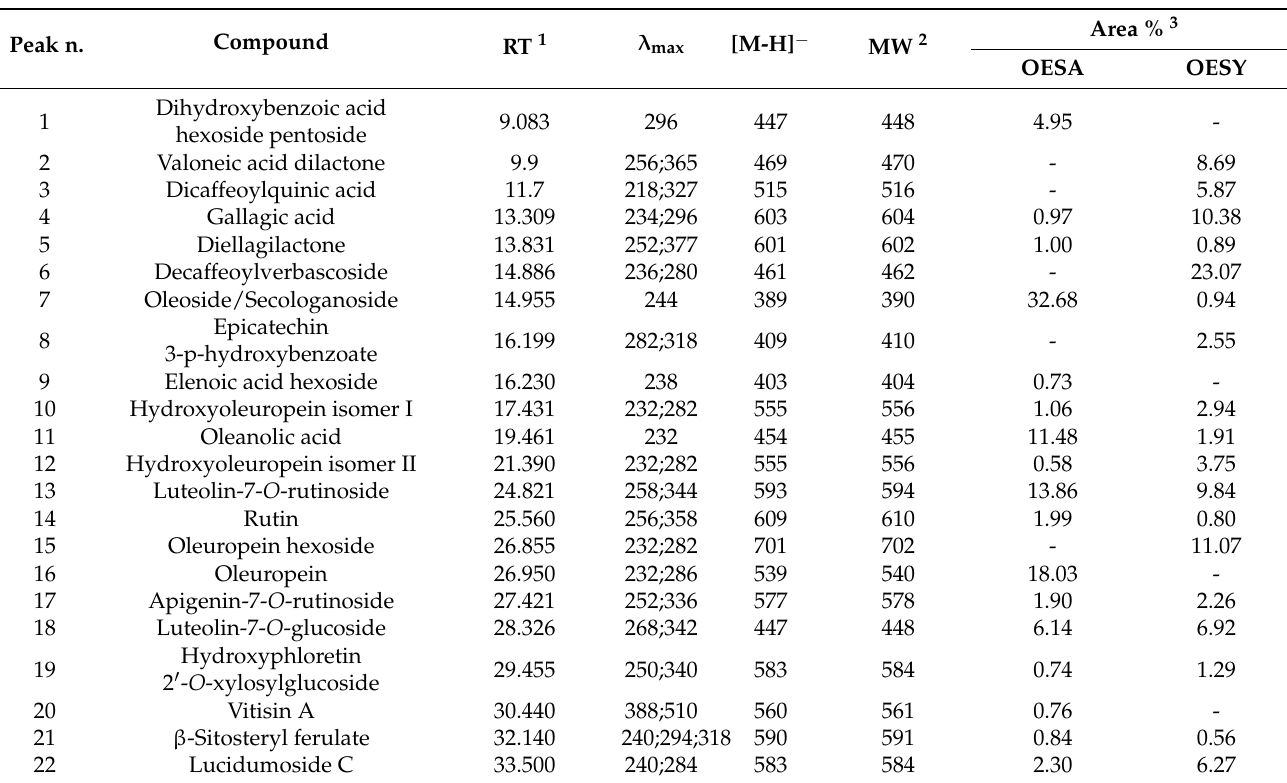
Table 1. Phytochemical profile of the leaf hydroalcoholic extract of O. europea L. var. sativa (OESA) and O. europea var. sylvestris (OESY) by LC-DAD-ESI-MS analysis. Peak